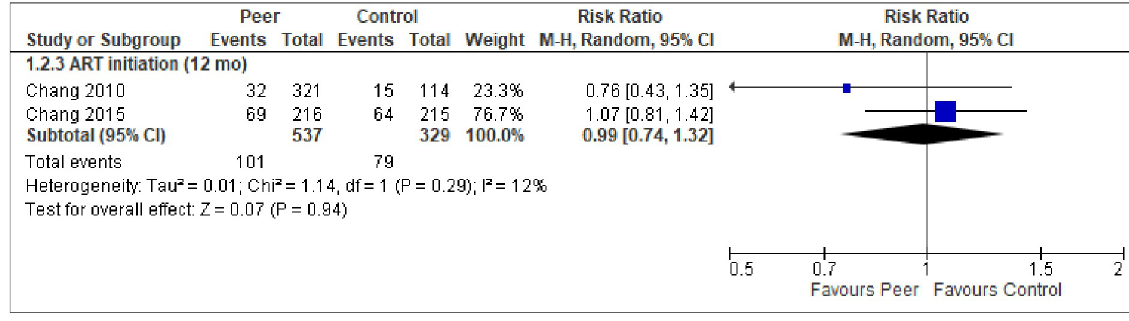
Fig 4. Meta-analysis of outcome ART